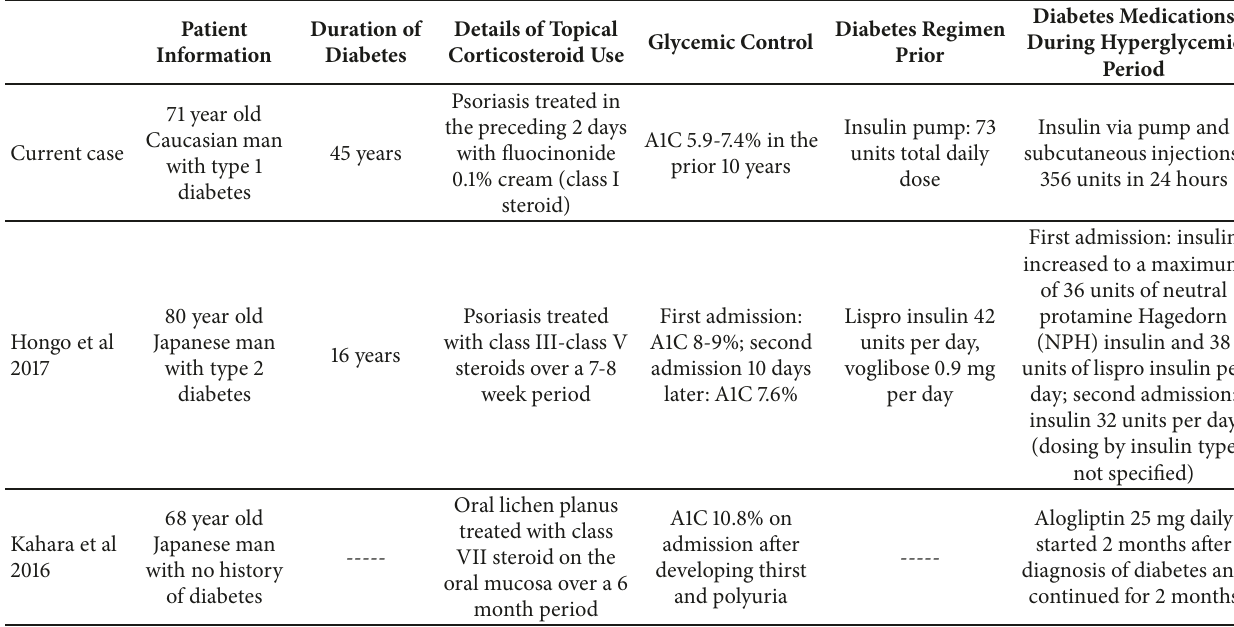
Figure 1: Glucose values (solid line) and insulin administered by the patient (R: regular insulin; G: glargine insulin; number denotes the number of units given) over time on the day prior to and the day of presentation. Table 1: Comparison of the current case with other cases of hyperglycemia related to topical corticosteroid